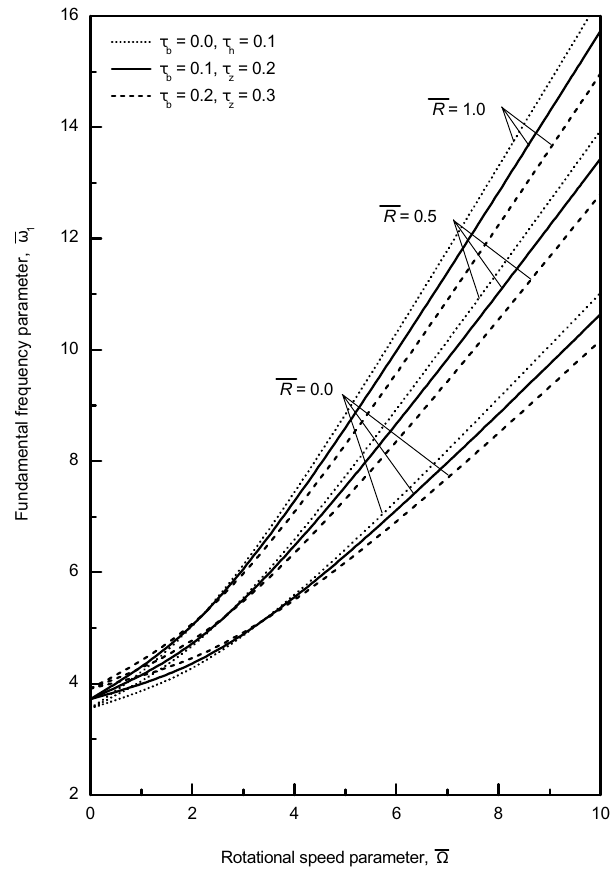
Fig. 3. Effect of unequal tapering on the fundamental frequency parameter of rotating Euler-Bernoulli